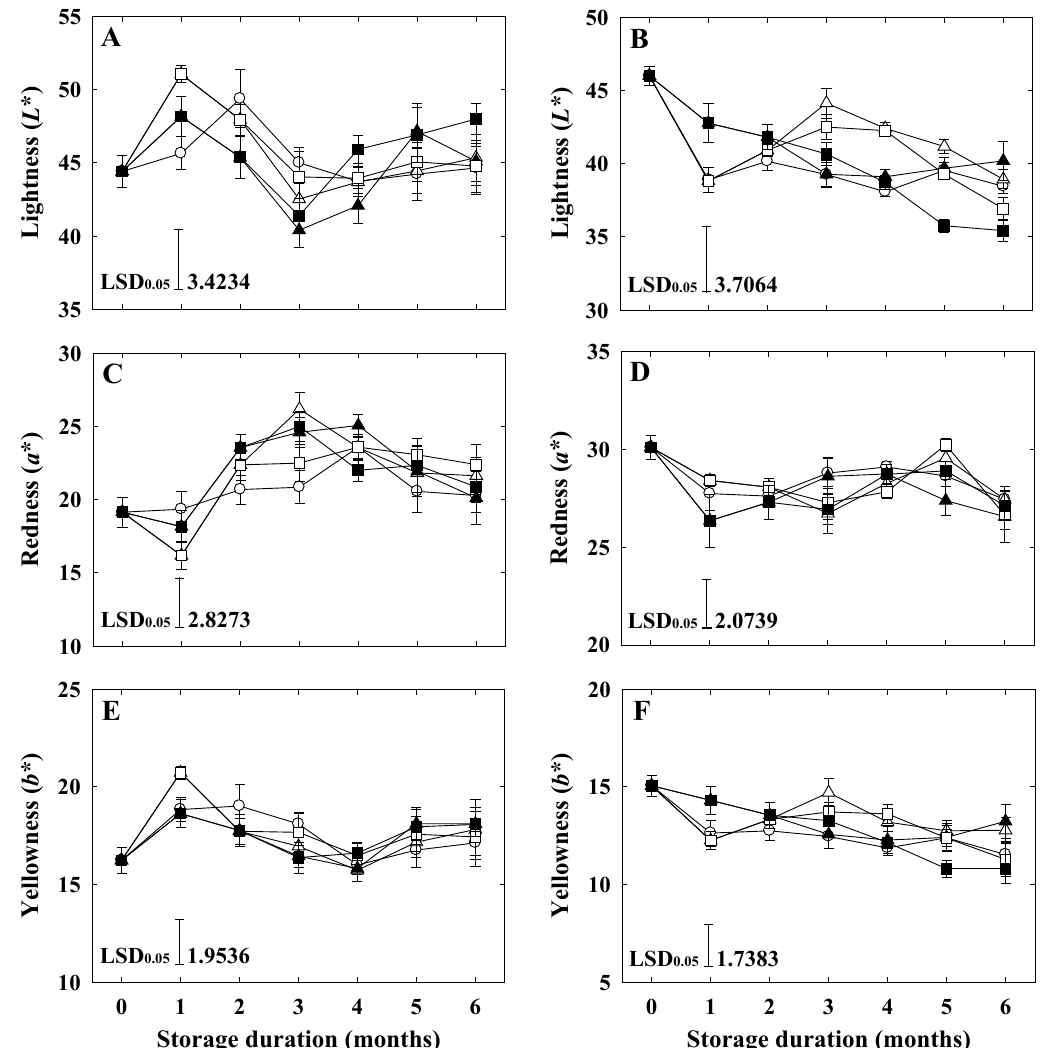
Figure 5. Fruit peel color properties ( L *, a *, and b *) of ‘Arisoo’ ( A , C , E ) and ‘Picnic’ ( B , D , F ) apples during cold storage at 0 ± 1 °C with 90–95% relative humidity for up to six months. Fruits were treated with 0.5 μL L −1 1- MCP (∆) and 1 μL L −1 1- MCP ( ▲ ) at harvest, and 0.5 + 0.5 μL L −1 1- MCP (□) and 1 + 1 μL L −1 1-MCP ( ■ ) at harvest and 2 months after storage, and untreated as control ( ○ ). Data are presented as mean ± standard error ( n = 15). L *: lightness; a *: red/green value; b *: blue/yellow value.